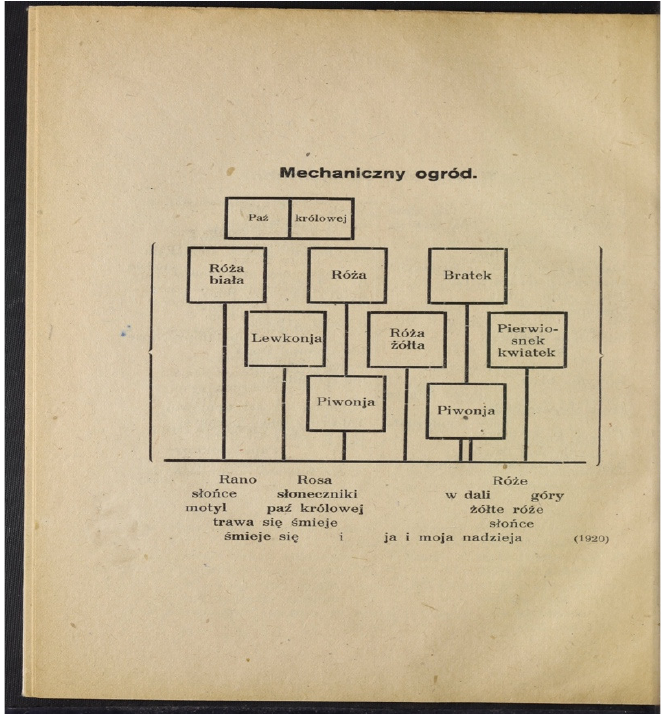
Figure 5. Czy˙zewski, Tytus. [1920] 1922. https://polona.pl/item/noc-dzien-mechaniczny-instynkt- Figure 5. Czy ż ewski, Tytus [1920] 1922. https://polona.pl/item/noc-dzien-mechaniczny-instynkt-el- ektryczny,NzIxMzg5NDQ/31/#info:metadata (accessed on 22 March 2022). elektryczny,NzIxMzg5NDQ/31/#info:metadata (accessed on 22 March